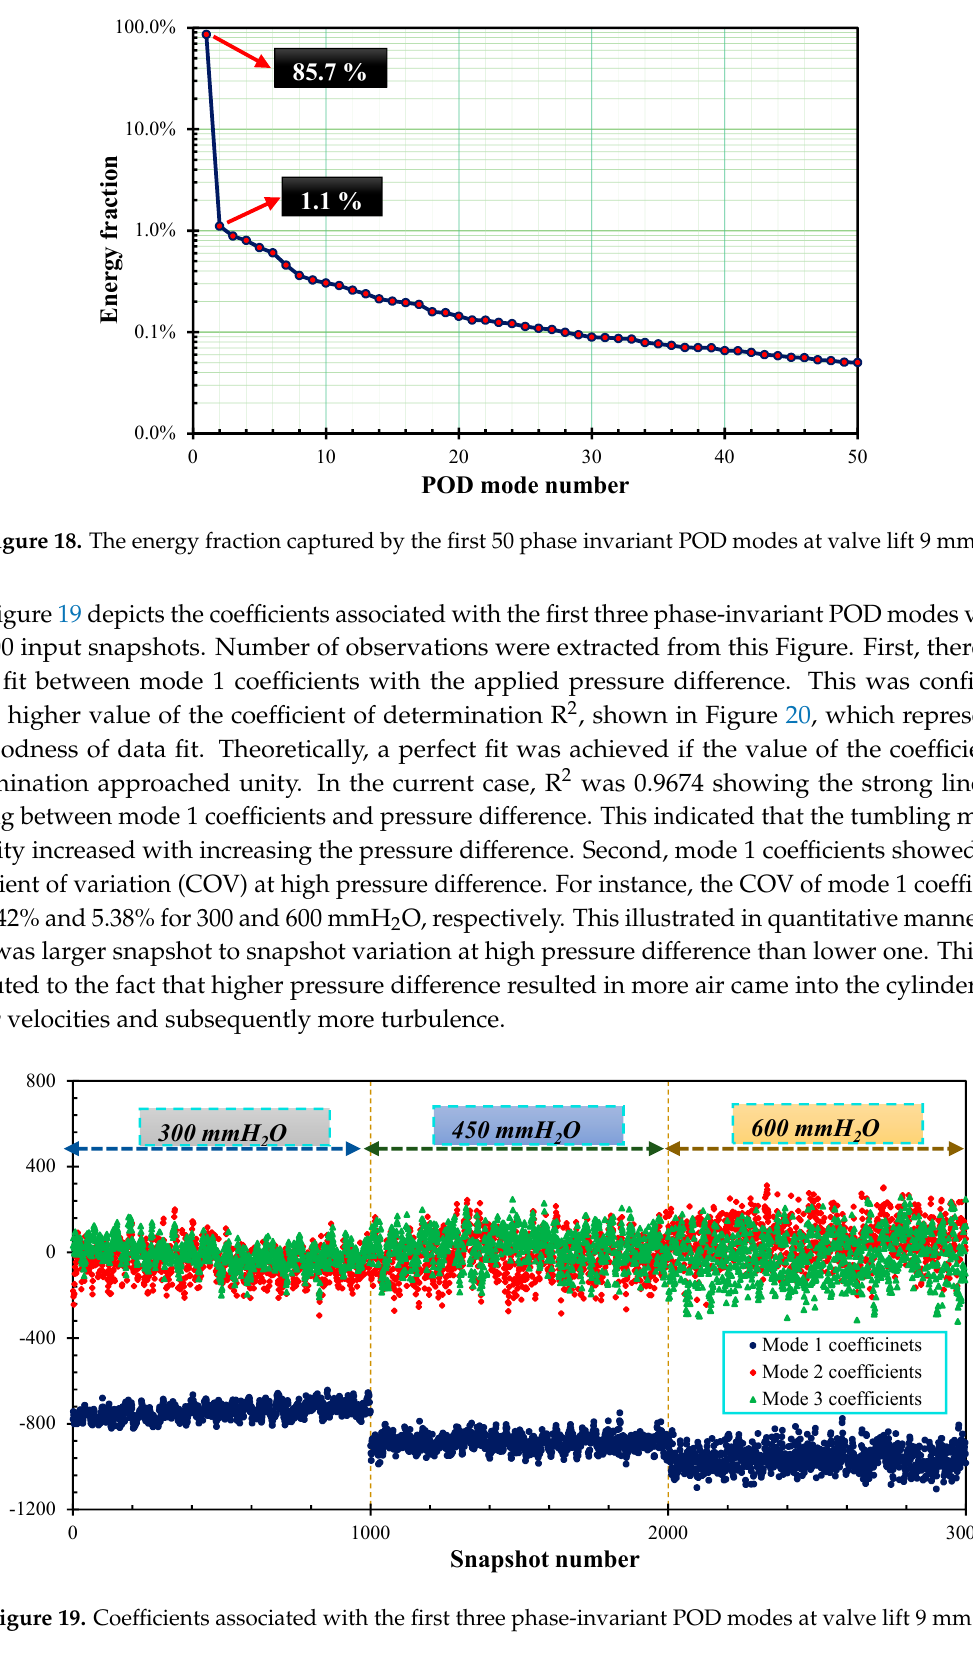
Figure 19. Coefficients associated with the first three phase-invariant POD modes at valve lift 9 mm.